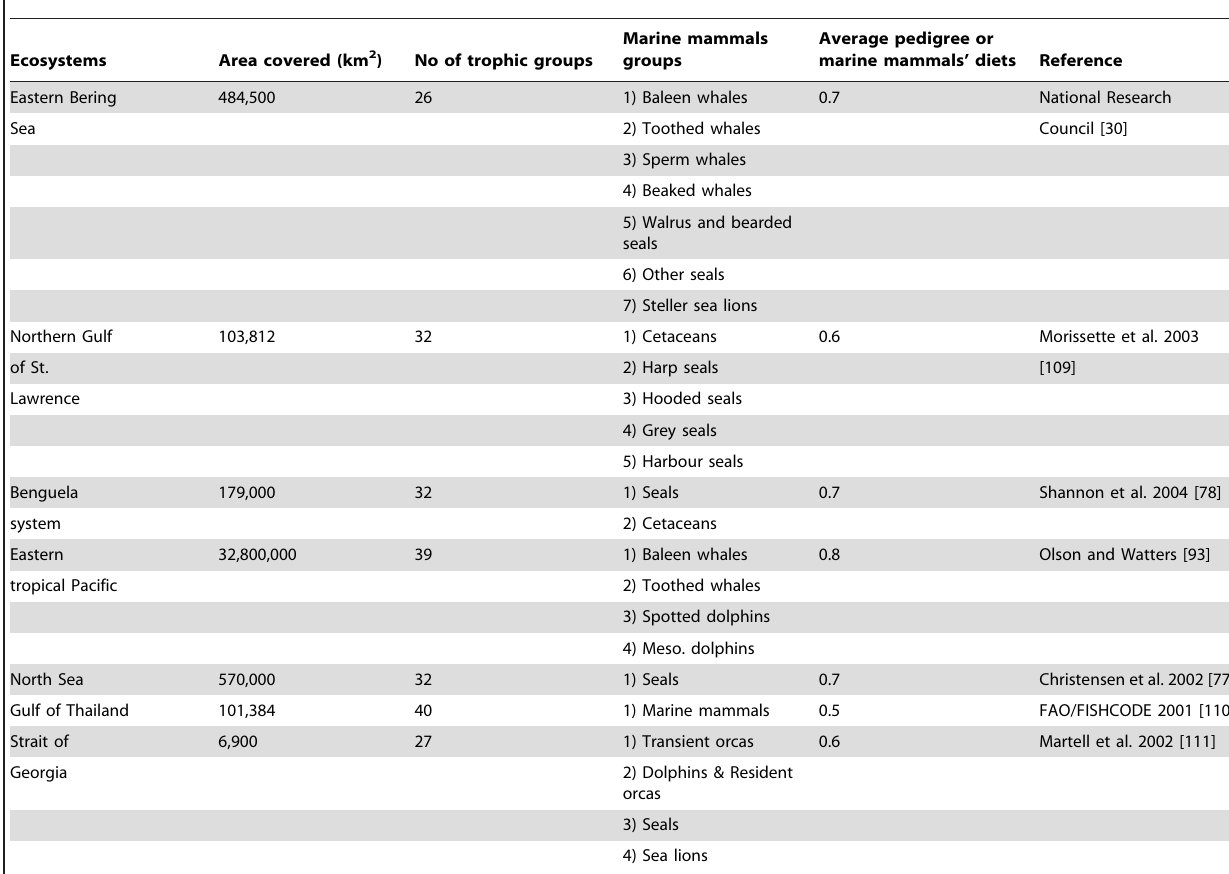
Table 1. Ecopath models used for analyses of marine mammals